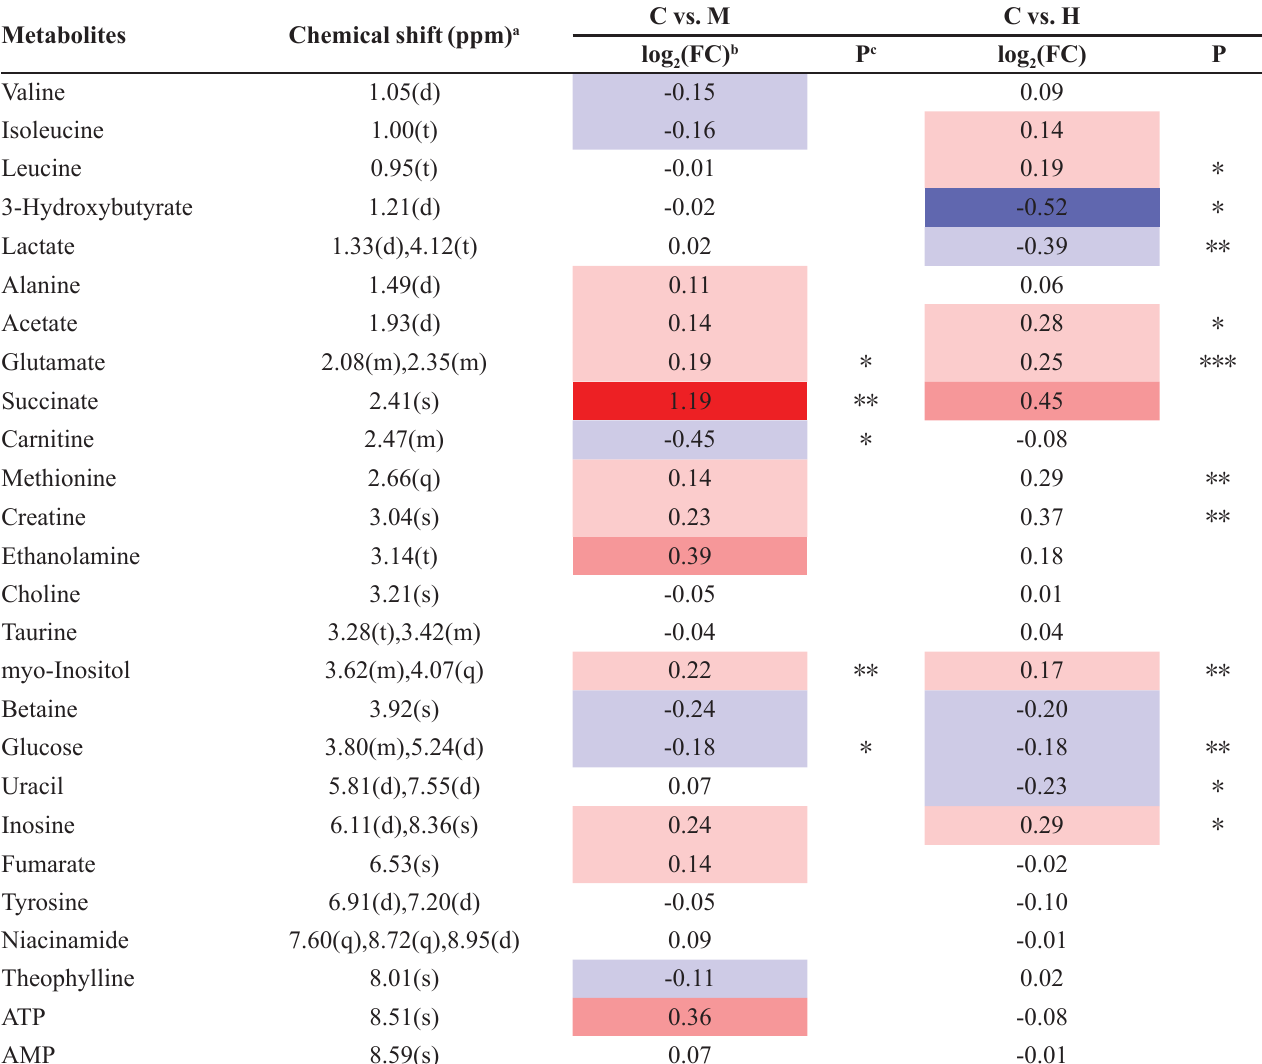
(FC) and p-values a Multiplicity: singlet (s), doublet TABLE I - Identified metabolites in the livers from different groups with log 2 (d), triplet (t), quartets (q), multiplets (m). b Color coded according to the log2(FC), red represents increased and blue represents decreased concentrations in glyphosate exposed groups. Color bar c p-values corrected by BH (Benjamini Hochberg) methods were calculated based on a parametric Student’s t-test or a nonparametric Mann–Whitney test (dependent on the conformity to normal distribution). *p < 0.05, **p < 0.01, ***p <